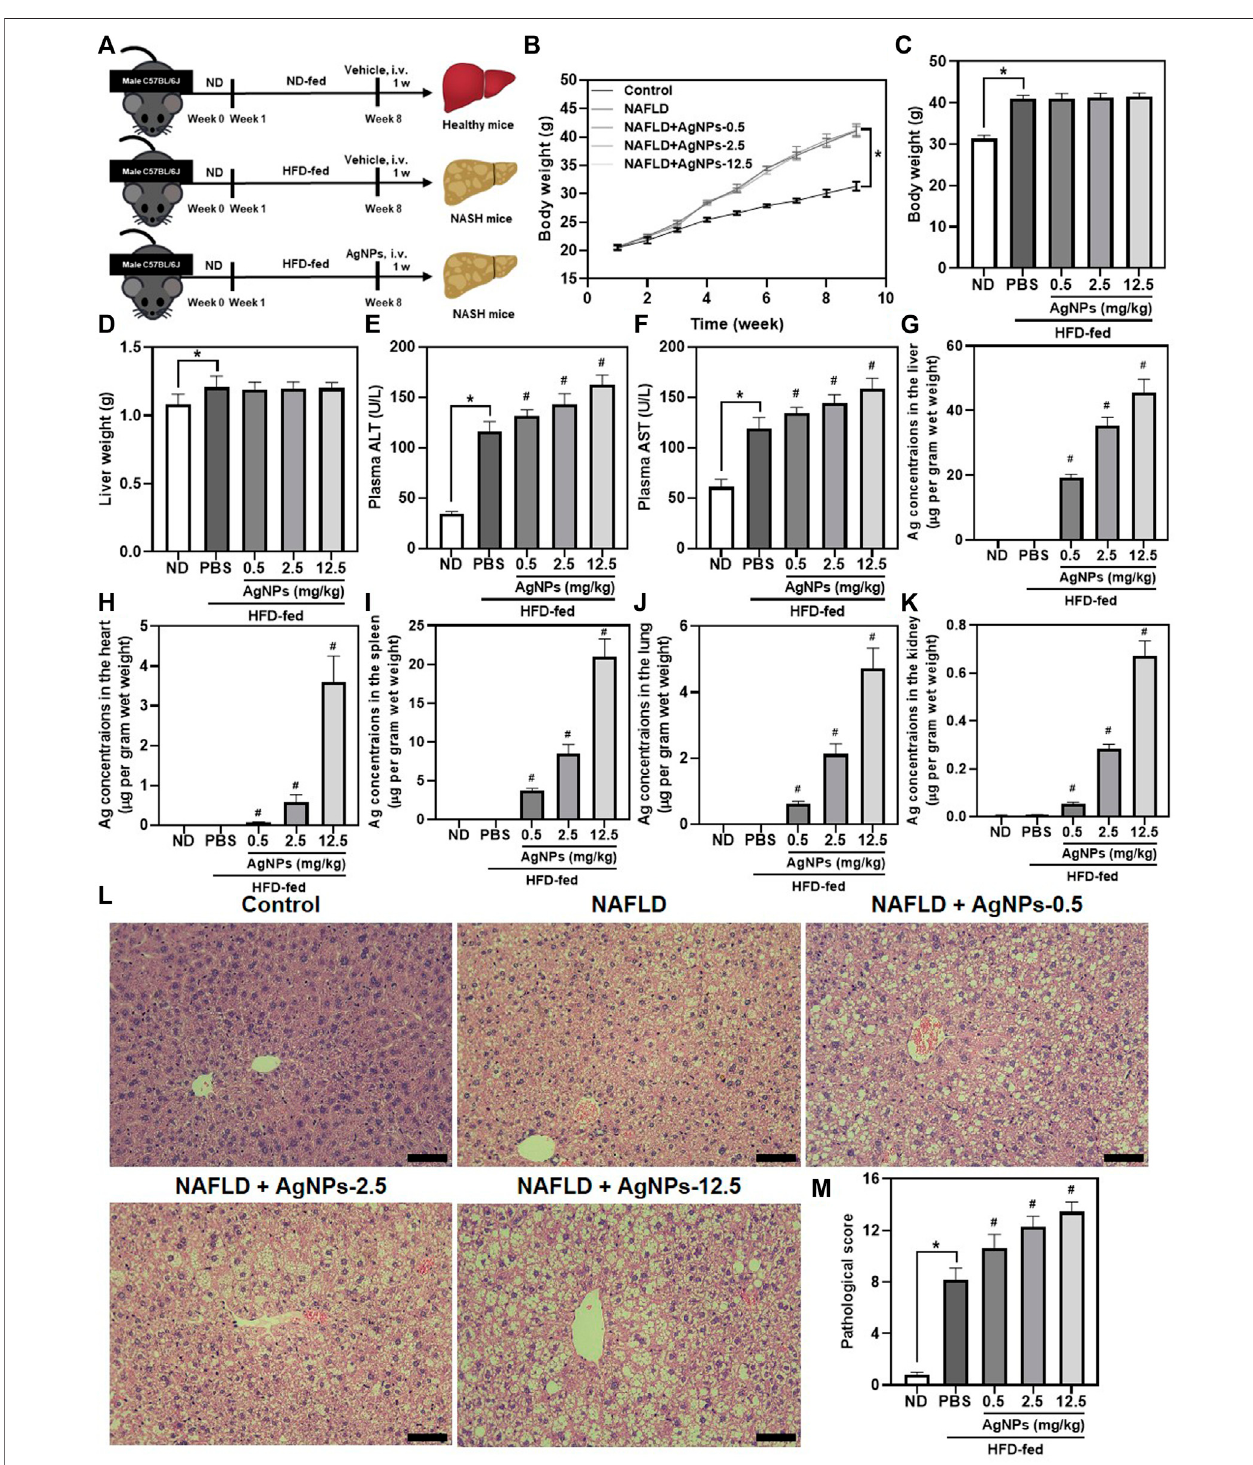
FIGURE 2| AgNPs aggravated HFD-induced hepatic dysfunction and liver injury in mice. (A) Schematic illustration of the murine model ofNAFLD induced by HFD along with AgNP treatment once at the concentration of 0.5, 2.5, and 12.5 mg/kg for 1 week. (B) The daily changes in body weight of the mice during the 8-weeks feeding and 1-week treatment course. The statistical analysis of the body weight (C) and liver weight (D) were obtained from the NAFLD mice after 1-week treatment. (E – F) TheliverfunctionoftheNAFLDwithoutandwithAgNPswasanalyzedbythelevelsofplasmaalanineaminotransferase(ALT)andaspartateaminotransferase (AST). ICP-MS analysis of the biodistribution of AgNPs at the liver (G) , heart (H) , spleen (I) , lung (J) , and kidney (K) of HFD-fed mice after intravenous injection at the concentrationof0.5,2.5,and12.5 mg/kgfor1 week.RepresentativeimagesofH&Estaining (L) andstatisticalanalysisofthepathologicalchanges (M) oftheliverinND- fed mice and HFD-fed mice treated with AgNPs. Scale bars, 50 μ m * p < 0.05 vs. ND-fed group; # p < 0.05 vs. HFD-treated group.